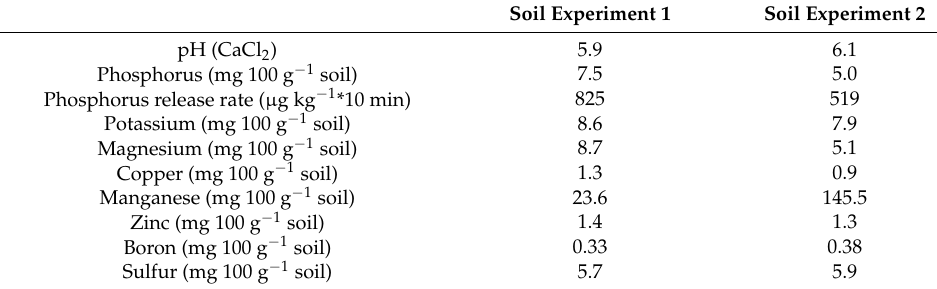
Table 1. Physico-chemical characteristics of the